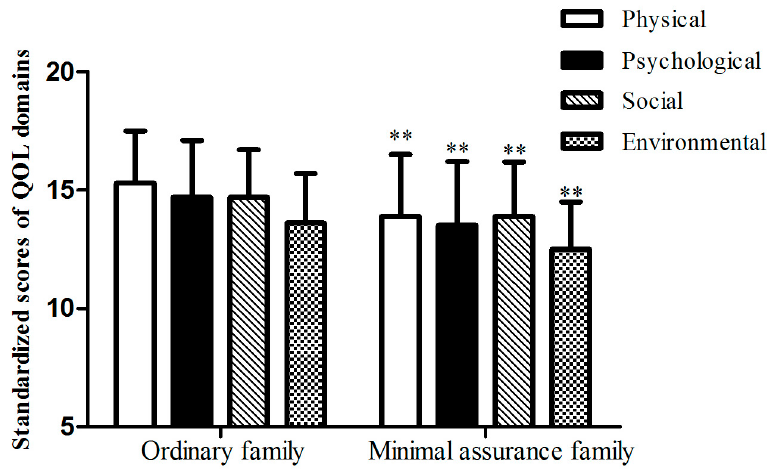
Figure 2. The mean scores of QOL domains in participants from minimal assurance families. ** p < 0.001.